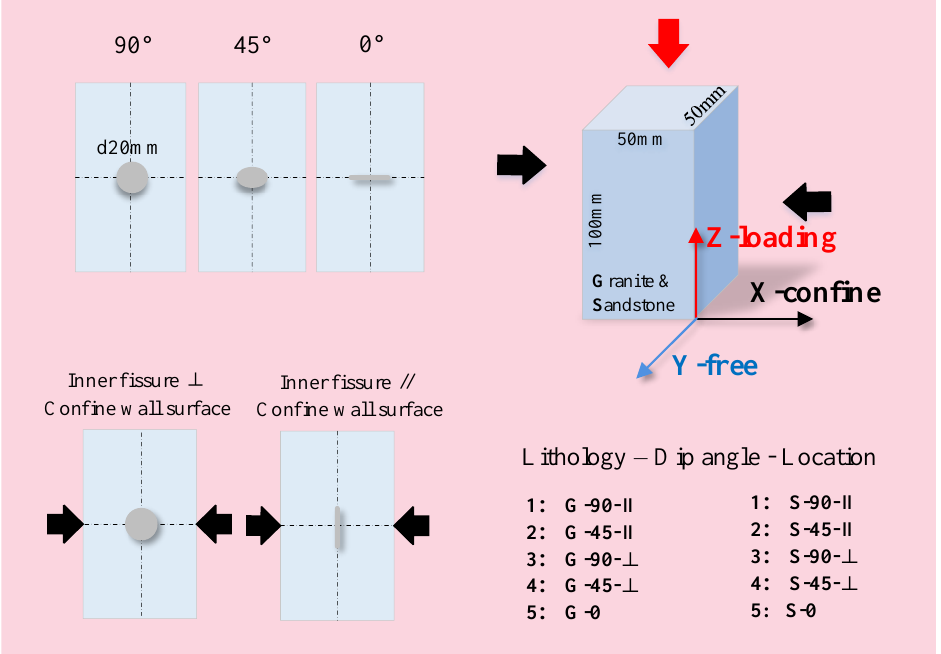
Figure 4. Test design details.